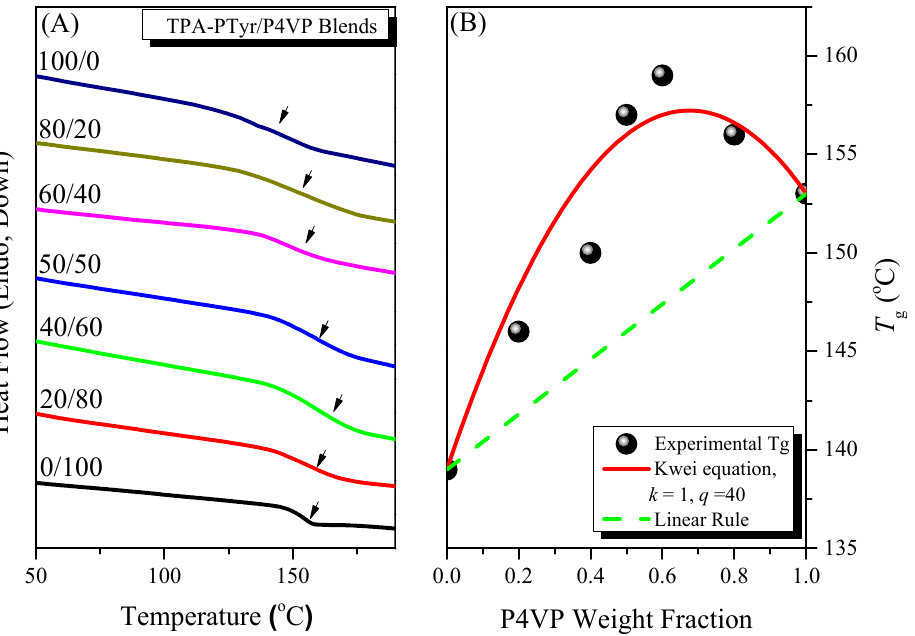
Figure 9. ( A ) DSC thermograms of miscible PTyr-TPA/P4VP blends (second heating scan); and ( B ) the T g behavior of the miscible PTyr-TPA/P4VP blends and that predicted by the Kwei equation.